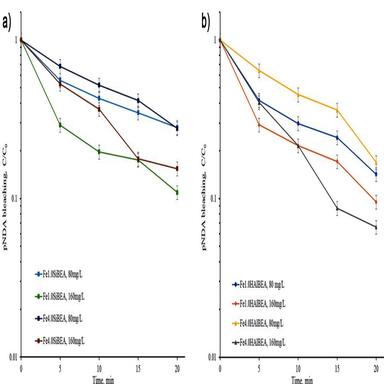
pNDA bleaching using different zeolites materials, a) FexSiBEA and b) FexHAlBEA, at different doses. Using 50 mM hydrogen peroxide at different zeolite loads: 80 and 160 mg L− 1 .